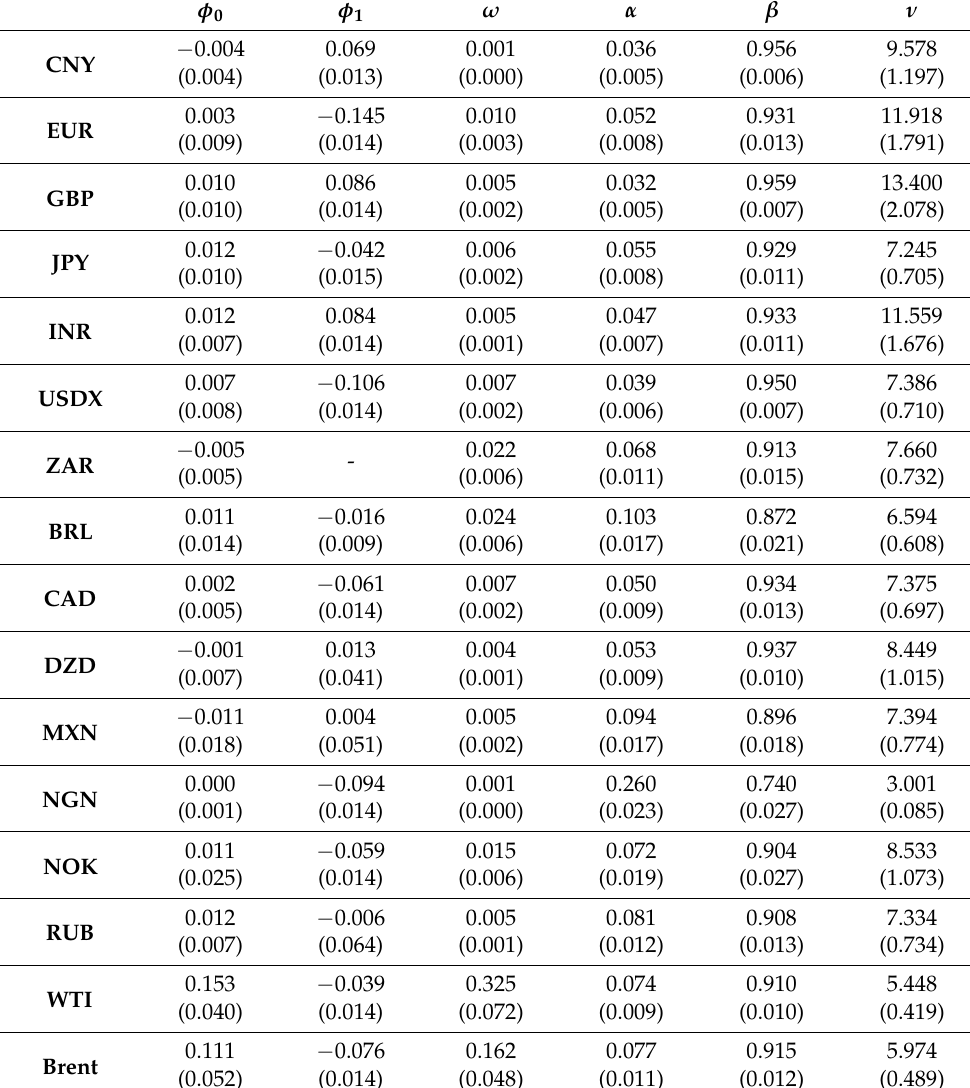
Table 2. Parameter estimation of marginal distribution based on AR-GARCH- t